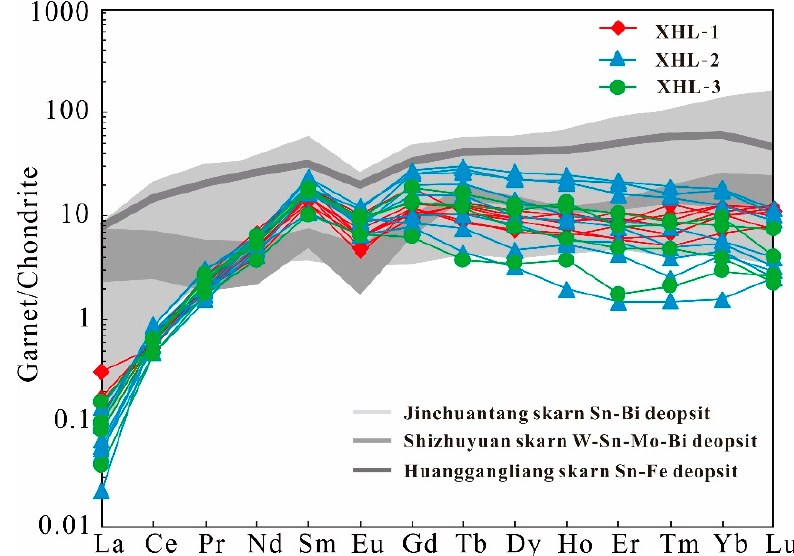
Figure 6. Chondrite-normalized REE patterns of the garnets from Xianghualing. Dashed area indicates the Chondrite-normalized REE partition curves of the garnets from other Sn-rich deposits including Jinchuantang [53], Shizhuyuan [51] and Huanggangliang [55], which have been shown here for comparison. All data were normalized to the C1 chondrite values [50].